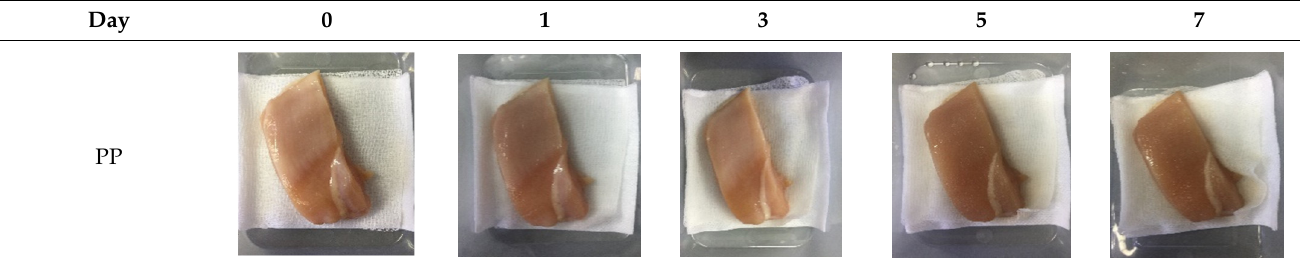
Table 3. The overall visual quality of chicken breast fillets stored in PP container and PBS/TPS film laminated tray during storage at 4 °C for seven days.